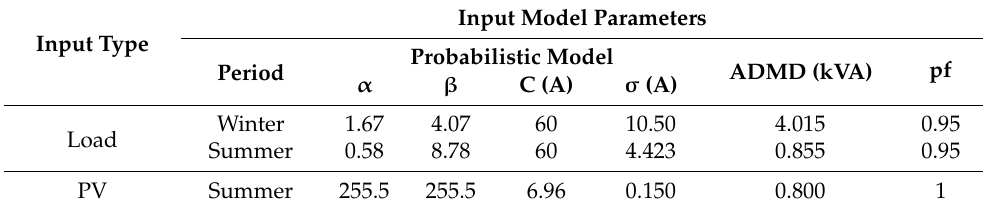
Table 3. Load and PV statistical model parameters.